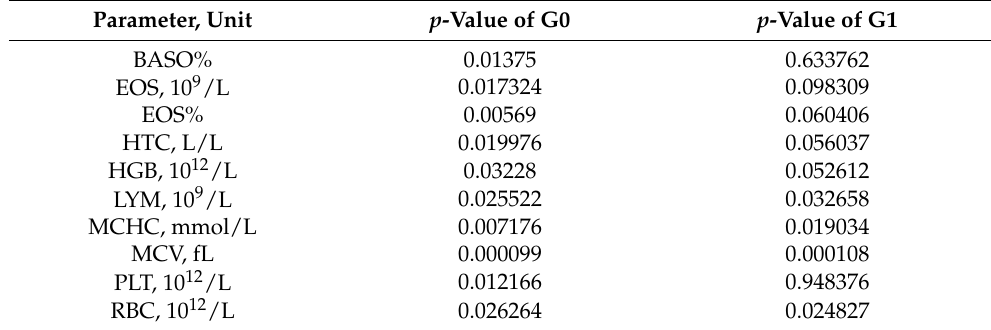
Table 2. Results of Friedman’s ANOVA and post-hoc tests for the supplemented (G0) and control group (G1) in a blood hematological analysis.